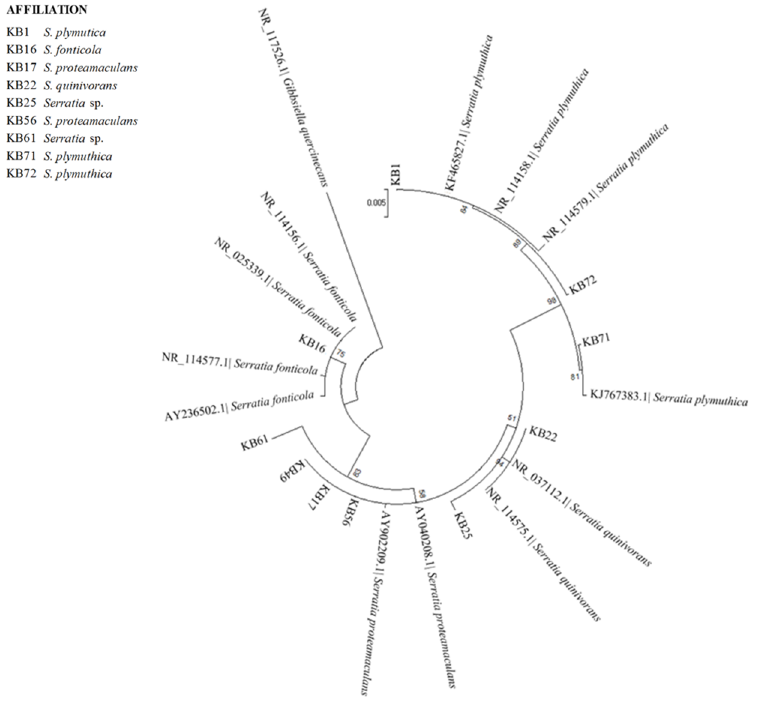
Fig 3. Maximum Likelihood phylogenetic dendrograms of KB strains belonged to Serratia based on 16S rDNA sequences. Bootstrap values calculatedfor 1000 replications(values lower than 50 are not shown). Bar, 5 nt substitution per